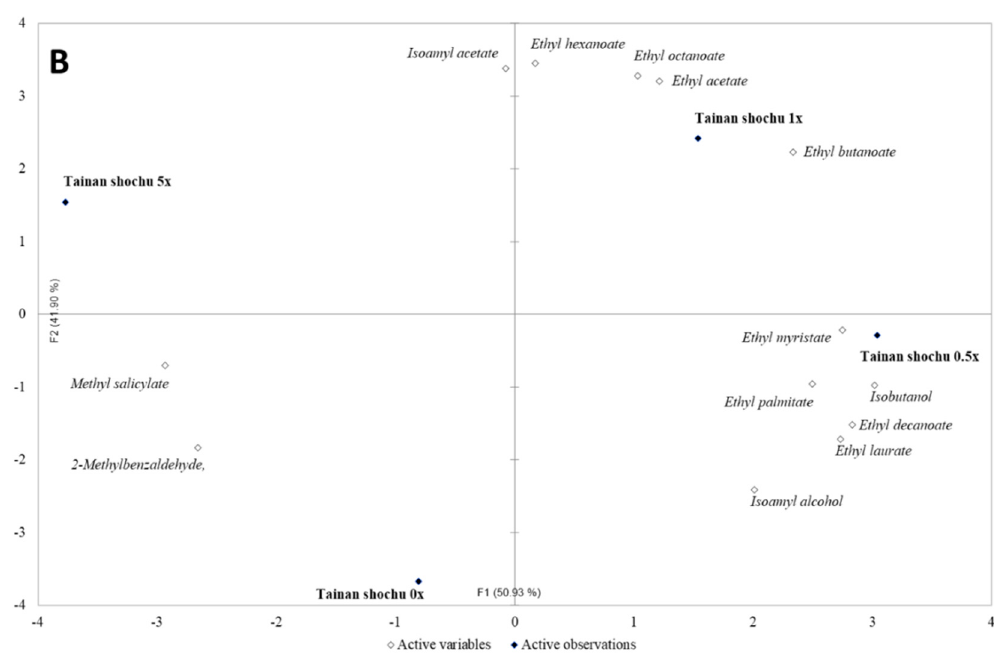
Figure 1. A bi-plot by principal component analysis of volatile compounds for the Taiwanese rice shochu samples with different DOWC concentration selected by GC/MS. ( A ) Taichung No. 10 rice shochu; ( B ) Tainan No. 11 rice shochu.